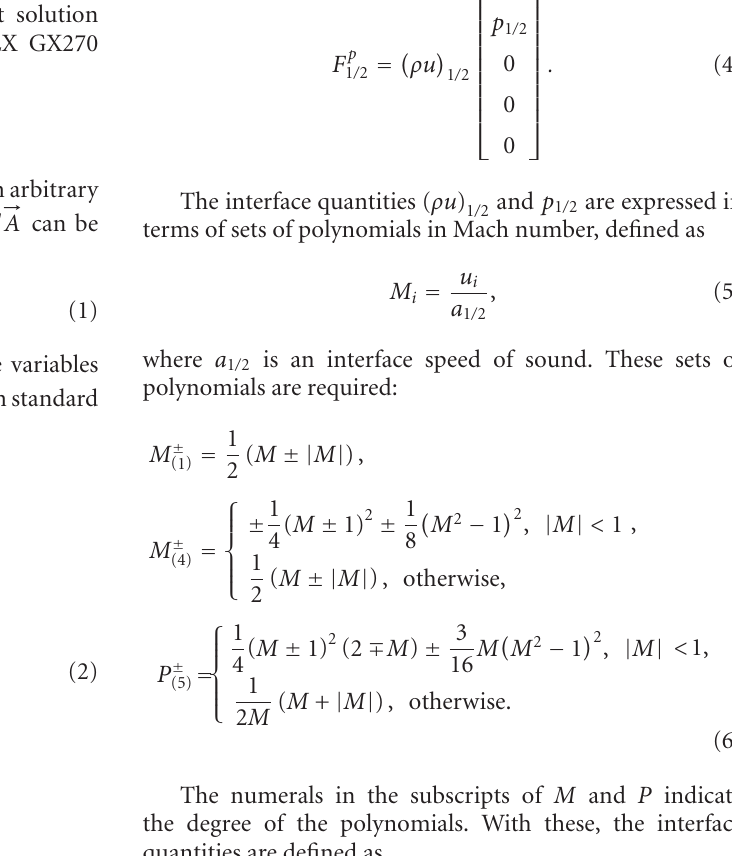
coarser grids for a constant grid resolution, it, being found that the total grid sizes, especially in the y direction, depend on the turbulence model used. According to the present study, the average value of the first-layer cell, y+, closest to the boundary surface was 0.2 with the exact solution for turbulence models [13]. The DELL OPTIPLX GX270 workstation was used for the